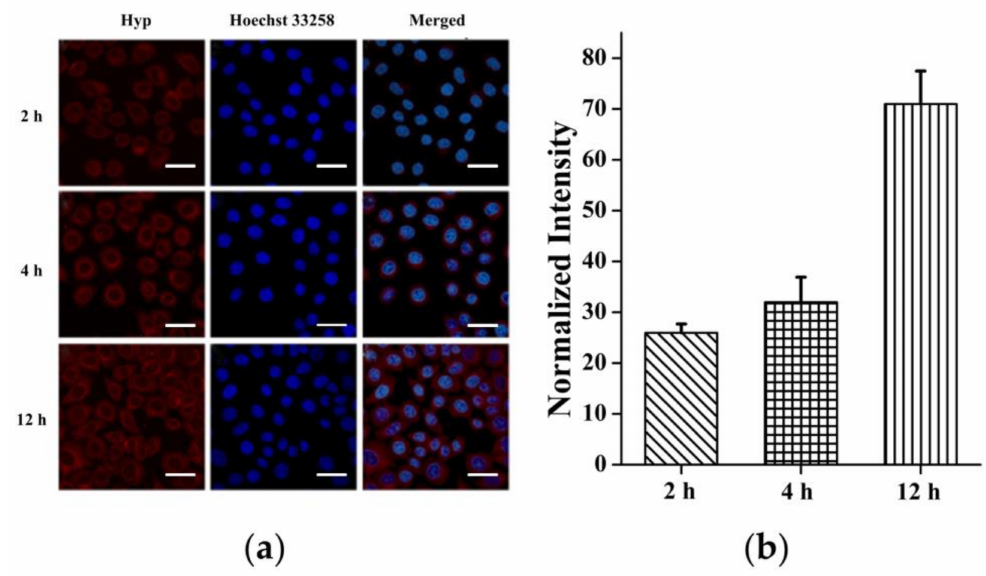
Figure 3. ( a ) CLSM images of HepG2 cells after various periods of incubation with CeONR@PDA-Gal / Hyp (2, 4, and 12 h), respectively. Scale bar: 20 µ m. ( b ) Quantitative analysis of the fluorescence of Hyp in HepG2 cells by Image-Pro Plus (n =